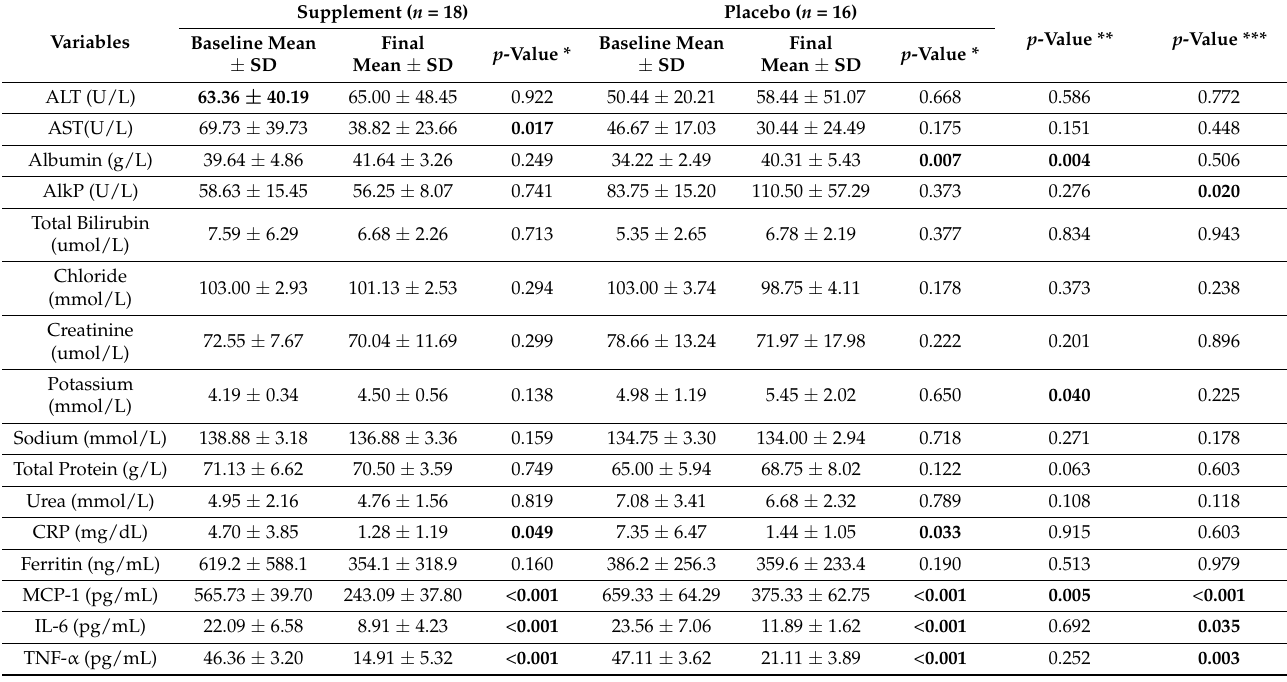
Table 4. Biochemical, inflammatory parameters, and cytokines levels before and after intervention in both study groups. Variables